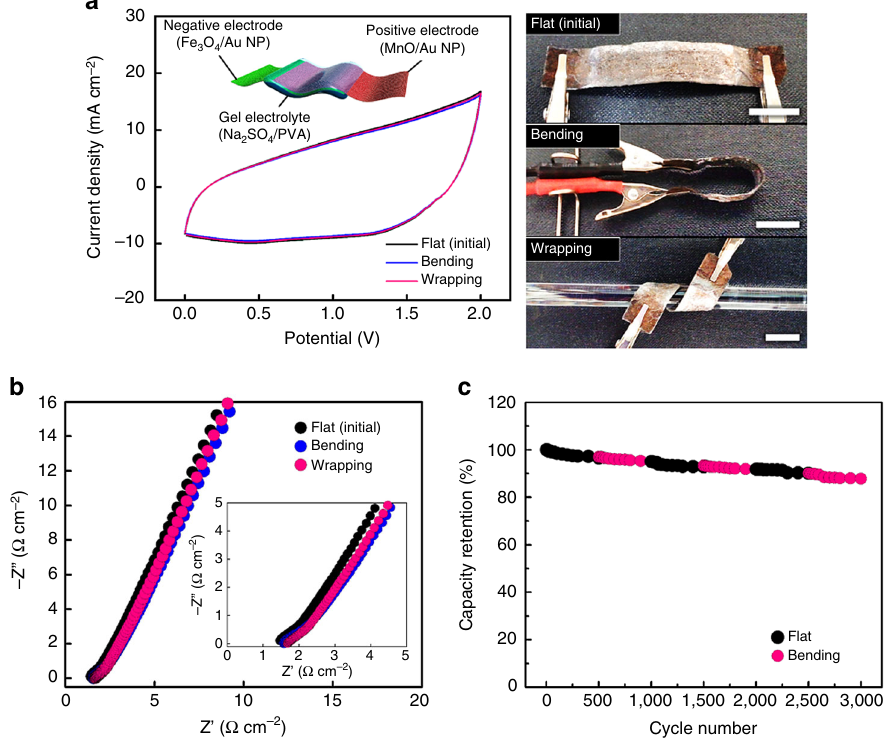
Fig. 6 Mechanical properties of the MP-ASCs. a CVs of the solid-state MP-ASCs at a scan rate of 50 mV s − 1 recorded under fl at (initial), bending and wrapping conditions. The scale bars in the photographs ( right ) correspond to 1 cm. b Nyquist plot of the solid-state MP-ASCs with different fl exible conditions. c Cycle retention test of the solid-state MP-ASCs with different bending conditions at a scan rate of 100 mV s −